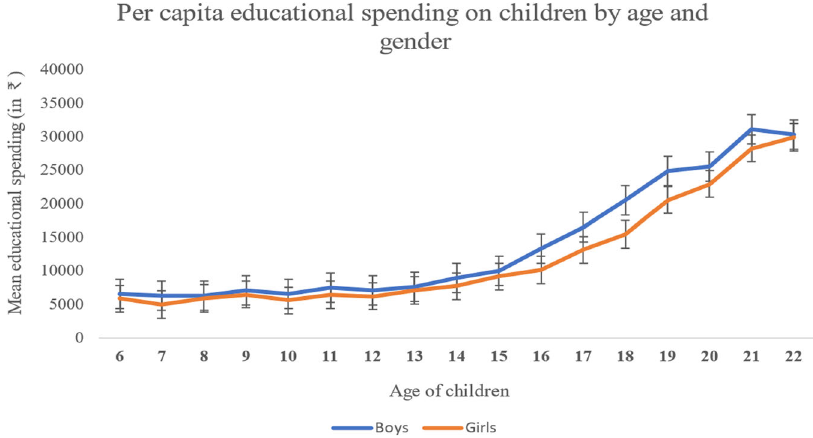
Fig. 3 Unadjusted household per capita education spending of 6 – 22 years age children by gender (2017 – 18),